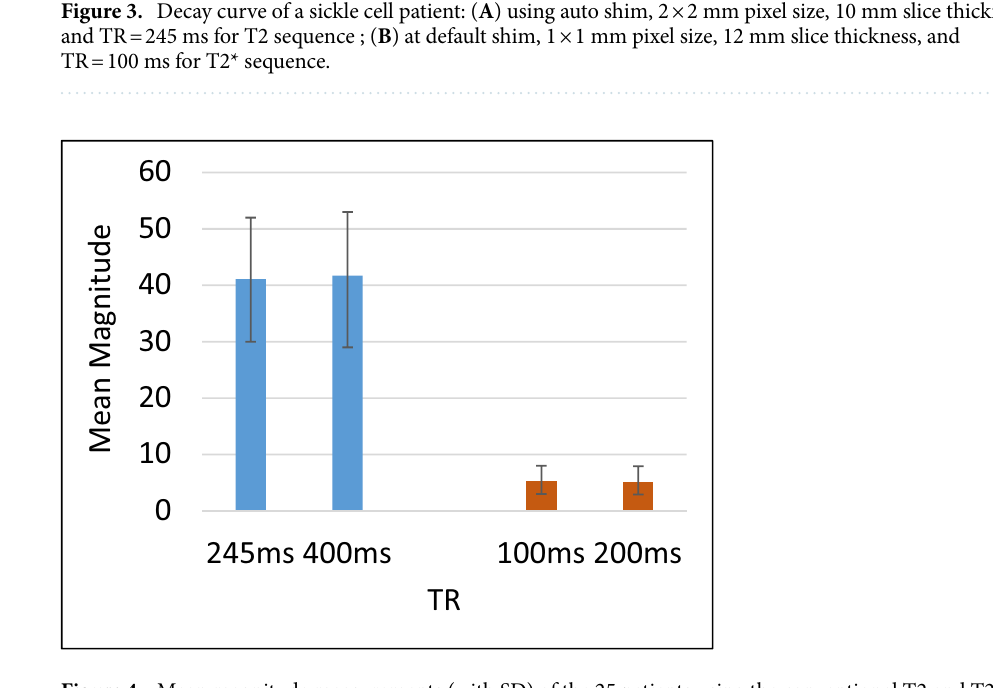
Figure 4. Mean magnitude measurements (with SD) of the 25 patients using the conventional T2 and T2* sequences versus the new optimised